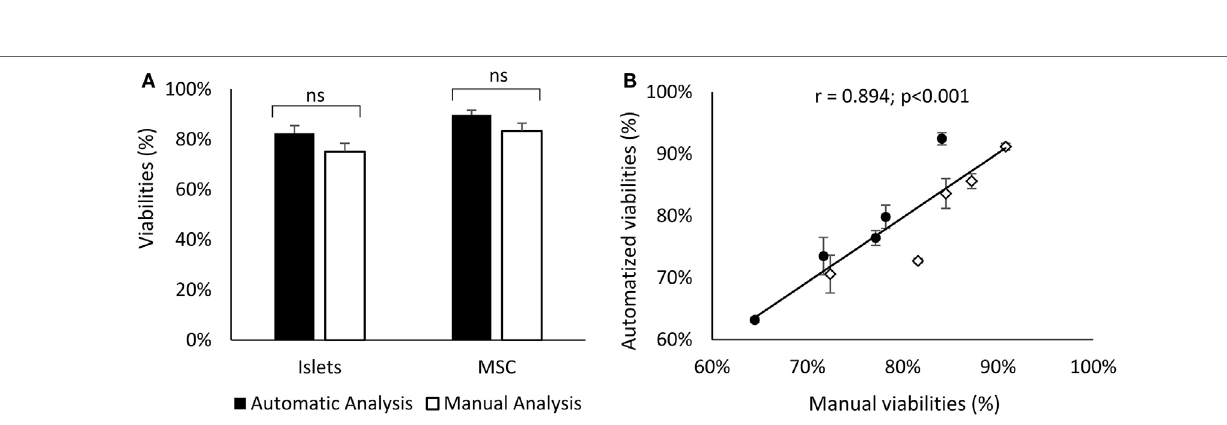
FIgURe 2 | Example of a picture obtained by confocal microscopy (A) and the identification of the different nuclei detected by the software (B) . Red: necrotic nuclei (IP); green: mesenchymal stem cells cytosol (Pkh); and blue: living nuclei (Hoechst